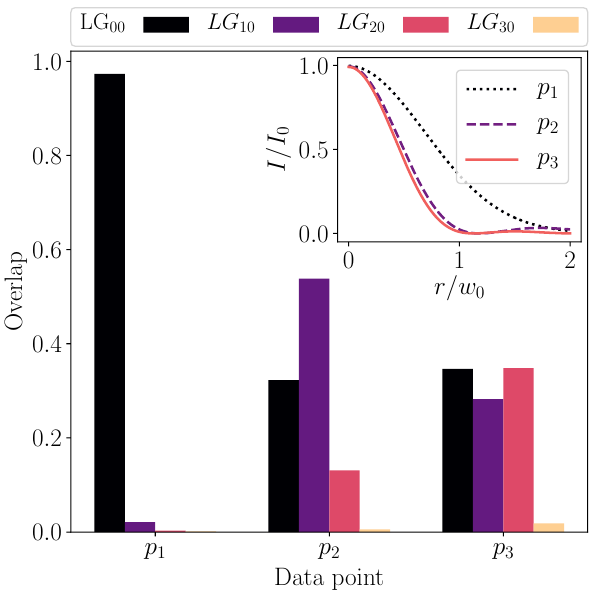
Figure 5: The overlap of different LG modes with the total cavity field at the three points, in ( ω , Λ ) space, marked by green crosses in Fig. 4 (b): p = ( 0.42, 0.49 ) , p = ( 0.62, 0.37 ) . The inset shows the resulting total intensity p 2 3 profiles of the modes in real space, which are radially symmetric. The intensity I is defined as the absolute square of the mode